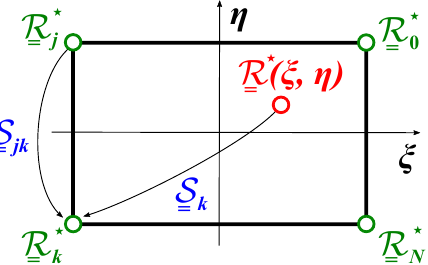
Figure 1. Interpolation of motion in a two-dimensional